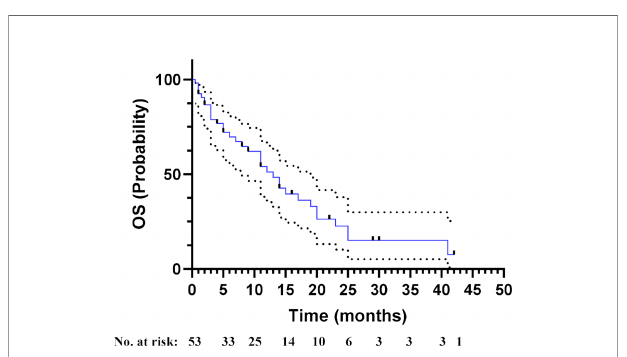
FIGURE 3 | Overall survival (OS) of the 53 patients with EGFR -mutated advanced non-small cell lung cancer (NSCLC) with leptomeningeal metastasis (LM) included in this study. Censored data are indicated by tick marks, and 95% CIs are shown by the dotted